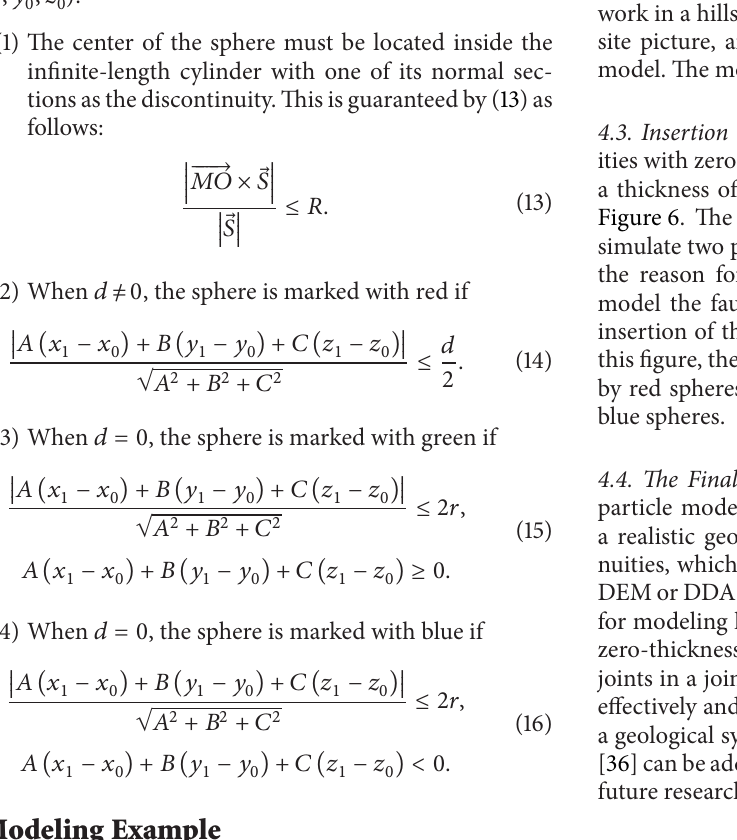
sphere is marked with red, green, or blue is calculated by the following steps, where the center of the sphere is assumed , 𝑦 , 𝑧 ) . 𝑂(𝑥 0 0 0